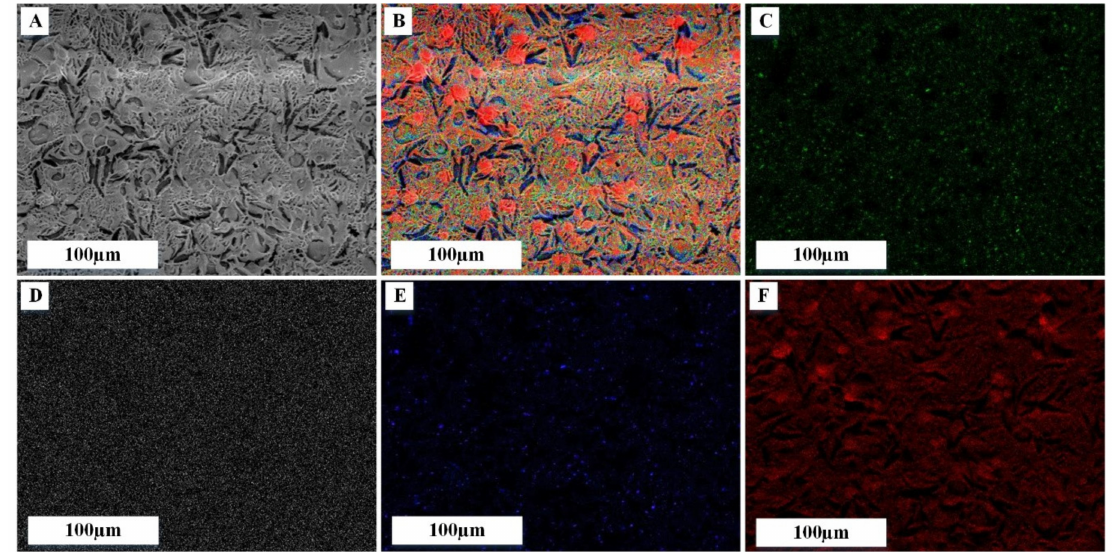
Figure 7. EDX mapping analysis on PRF/VANKA scaffold; ( A ) SEM image; ( B ) overall mapping elements on the same spot, corresponding to: ( C ) chloride, ( D ) potassium, ( E ) sodium and ( F ) oxygen